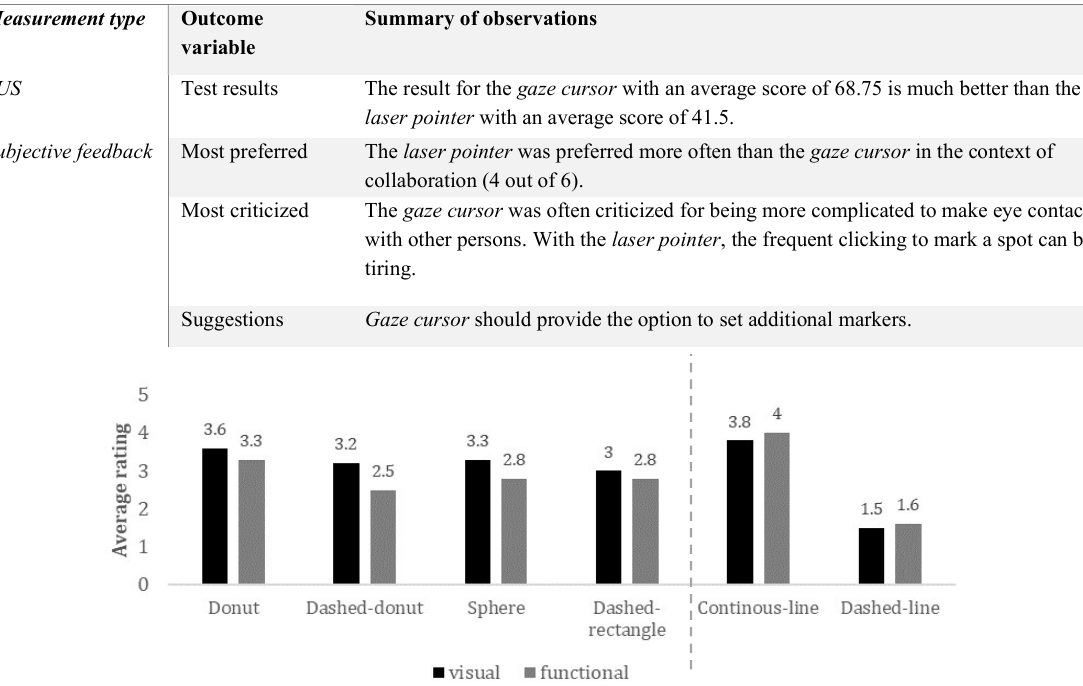
Table 2. Summary results from Session 2 where the participant is in the role of the communicator.